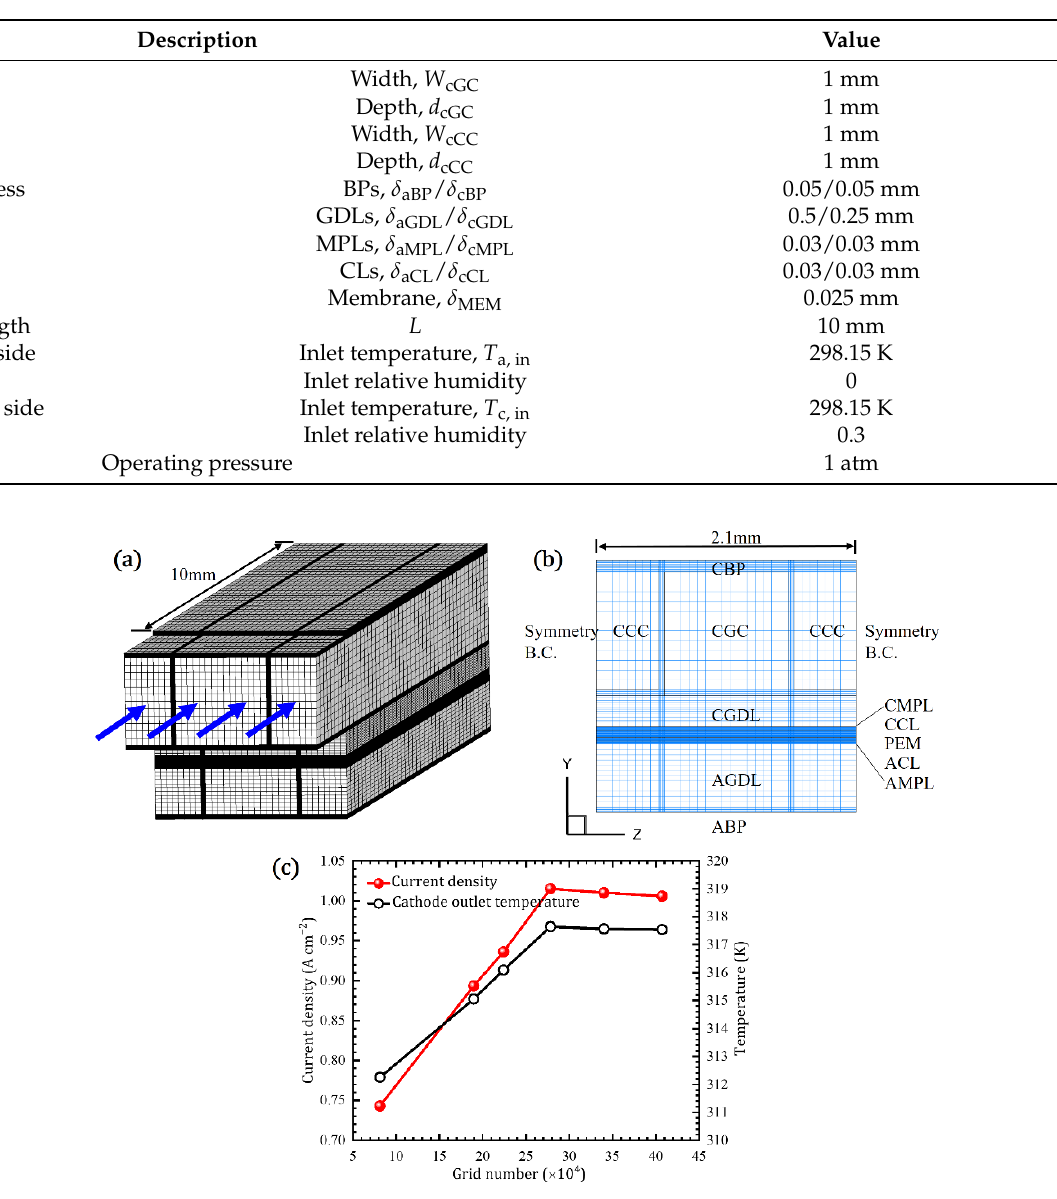
Table 5. Structural and operating parameters.